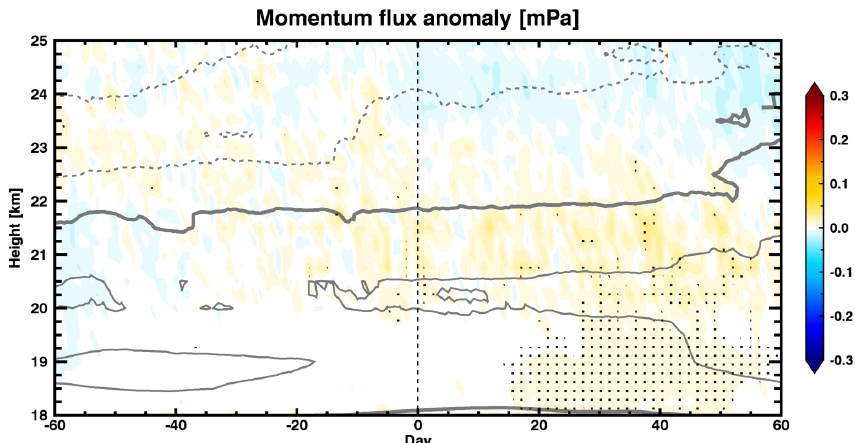
Figure 9. Composite momentum flux anomaly for events where OLR is less than 200Wm − 2 over at least 66% of the reference upstream area for Manus Island. Day 0 (dashed black line) is the first day this condition is satisfied. The anomaly is the difference from the mean over the entire data record. Stippling indicates where the anomaly is significant at the 95% level. Gray curves are the composite zonal mean zonal wind at 2.5ms − 1 spacing, with the 0ms − 1 contour bolded. See the text for more